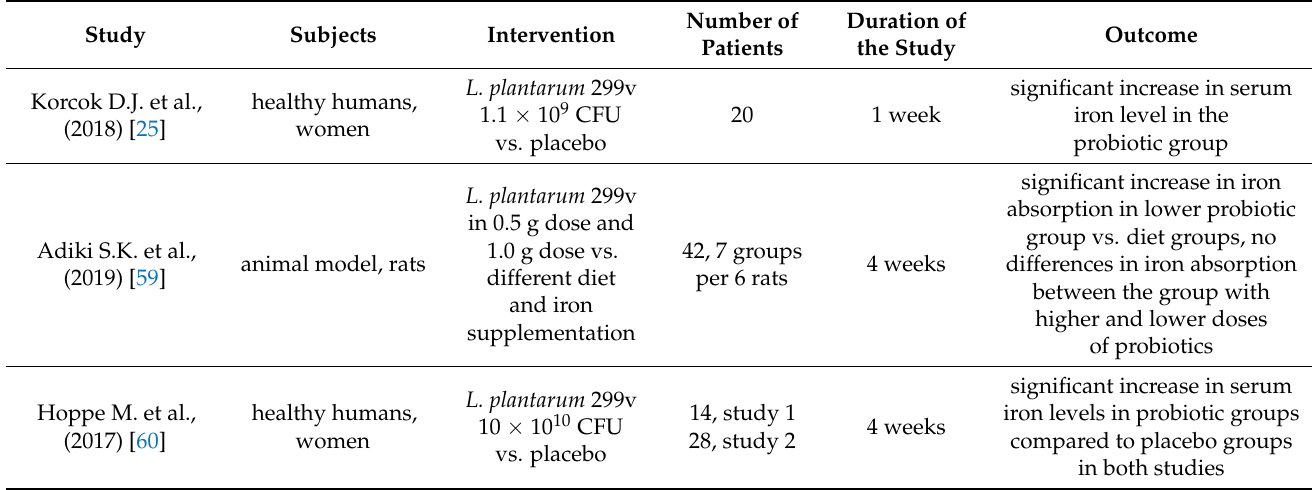
Table 3. Studies evaluating probiotics in